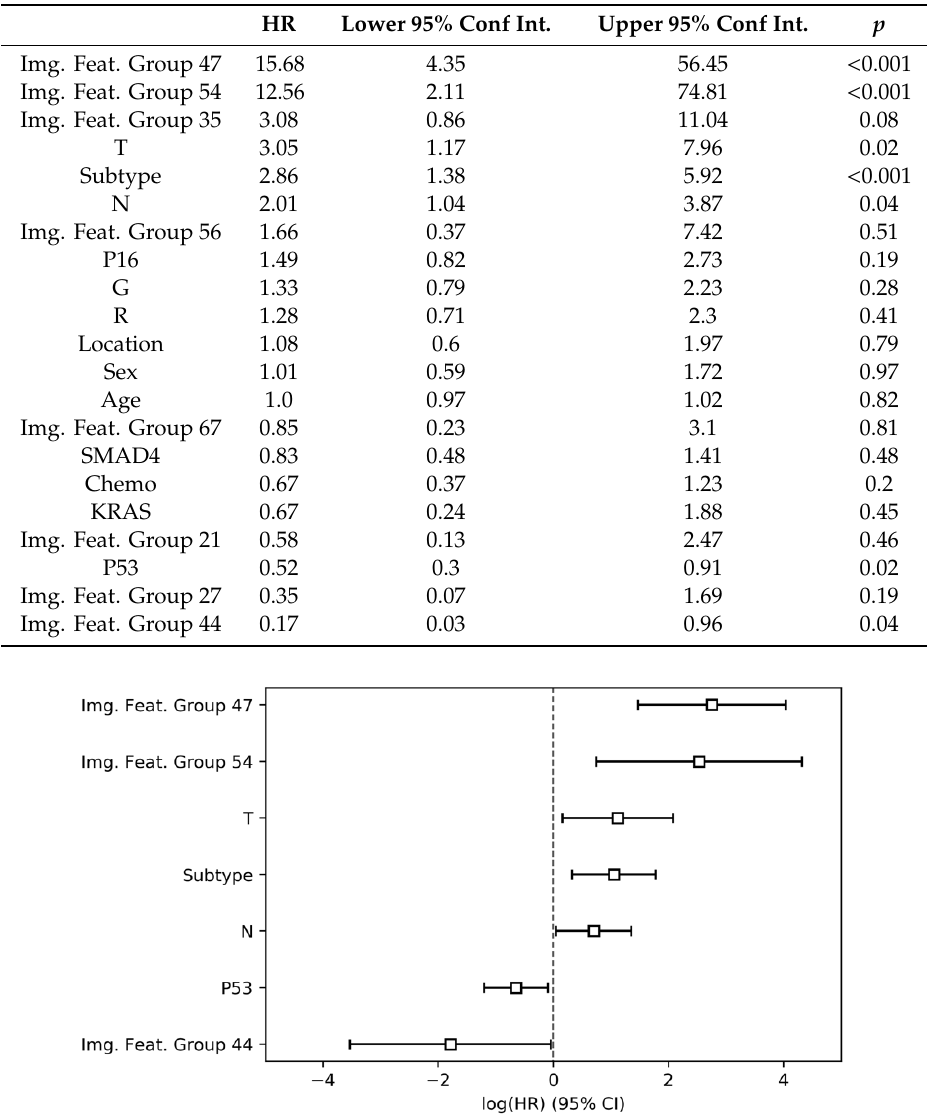
Table 5. Results of the Cox proportional hazards modelling for parameter group 4 (all parameters combined). Table 5. ResultsoftheCoxproportionalhazardsmodellingforparametergroup4(allparameterscombined). HR Lower 95% Conf Int. Upper 95% Conf Int. HR Lower 95% Conf Int.